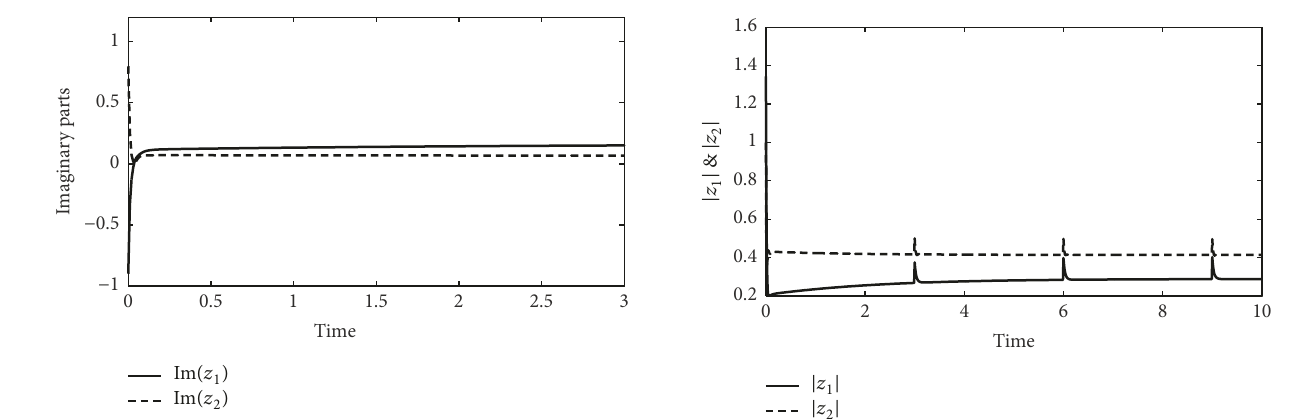
Figure 4: State curves of |𝑧 1 | and |𝑧 2 | with impulsive